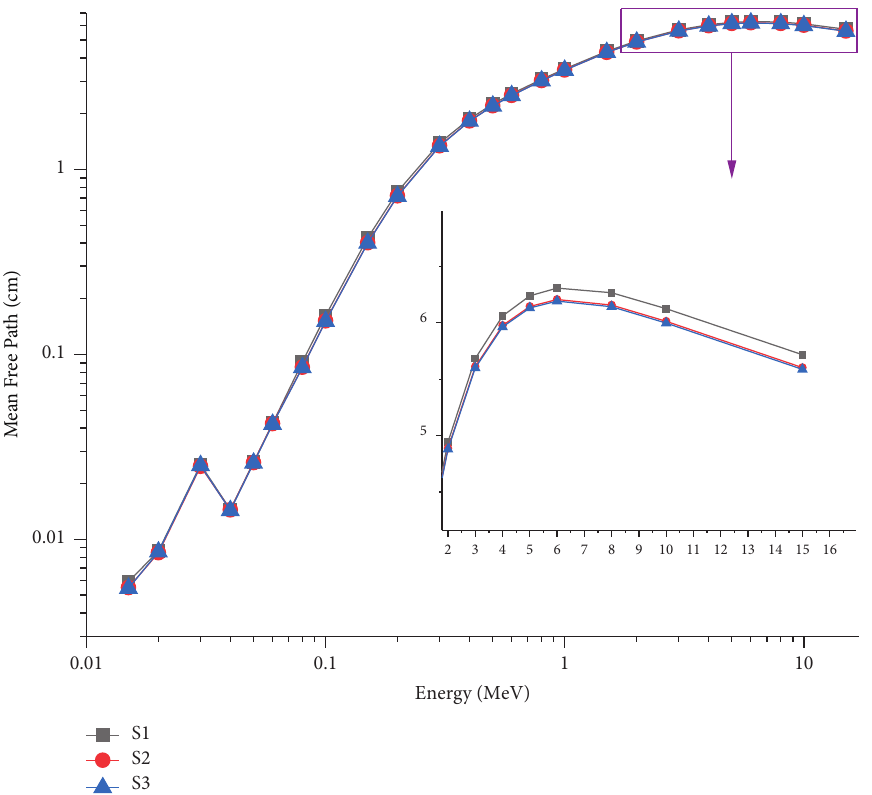
Figure 7: Variations of the mean free path (cm) with photon energy (MeV) for all S1–S3 glasses.